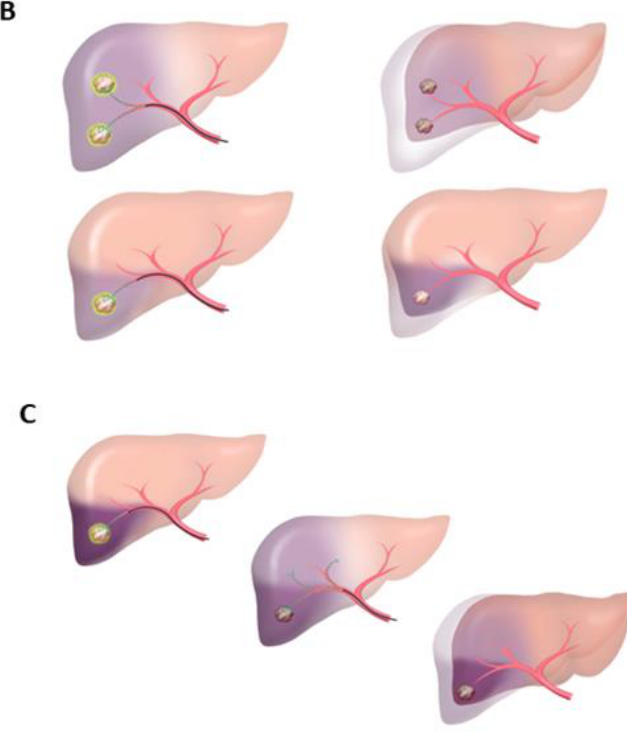
Figure 2. Various TARE procedures. ( A ) Types of TAREs: total (whole liver), bilobar (2 catheters), lobar or segmental and subsegmental; ( B ) Segmental TARE: before and after (healthy lobe hyper- trophy and diseased segment atrophy); ( C ) TARE in 2 phases: boost in LOE and lower dose in the corresponding lobe. Finally, atrophy of the diseased lobe and hypertrophy of the healthy lobe.